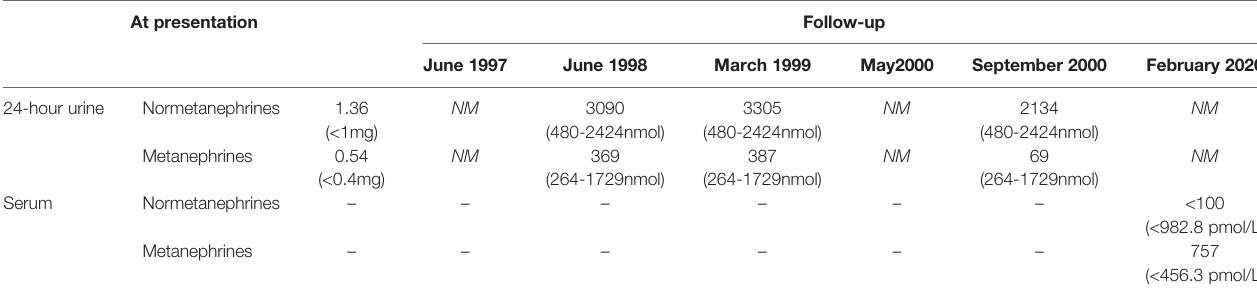
TABLE 2 | Serum and urinary catecholamines and metanephrines (reference range) at presentation and during follow-up of Patient 2. At